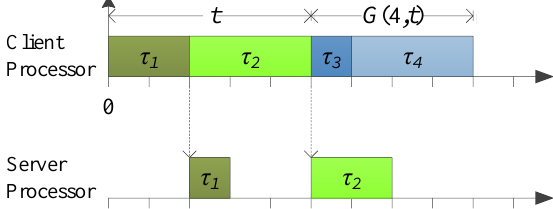
Figure 6 An example for illustrating the dynamic programming